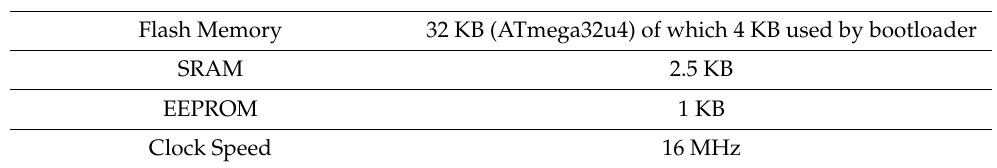
Table 4. Datasheet of the high-speed CMOS 16-channel analog multiplexer/demultiplexer CD74HC4067.